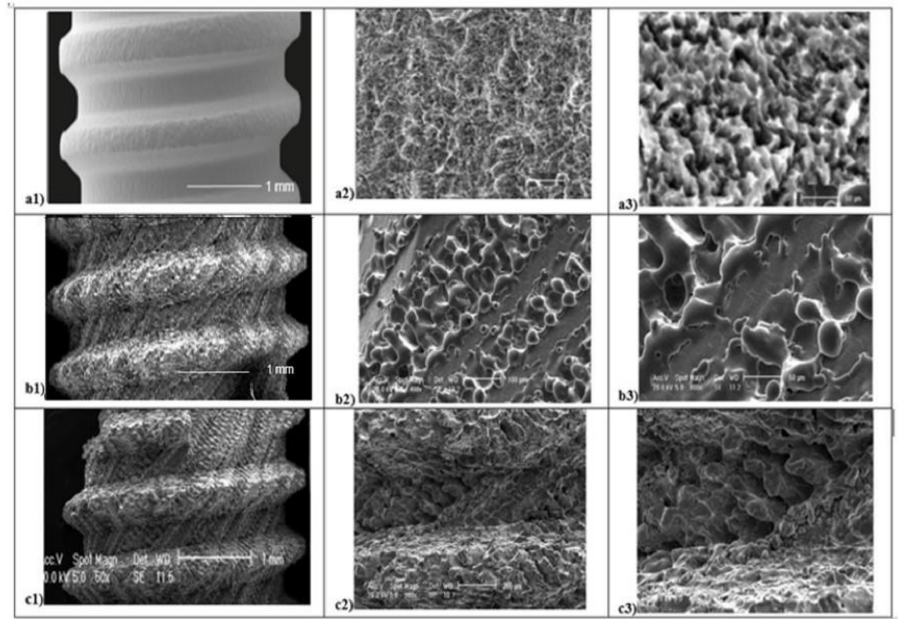
Figure 3. Scanning Electron Microscope (SEM) analysis of titanium surfaces at 50 × , 400 × , and 800 × : SBAE ( a1 – a2 – a3 ), L1 ( b1 – b2 – b3 ), and L2 ( c1 – c2 – c3 ) (black marked scale bars reported are equal for each set of magnifications).